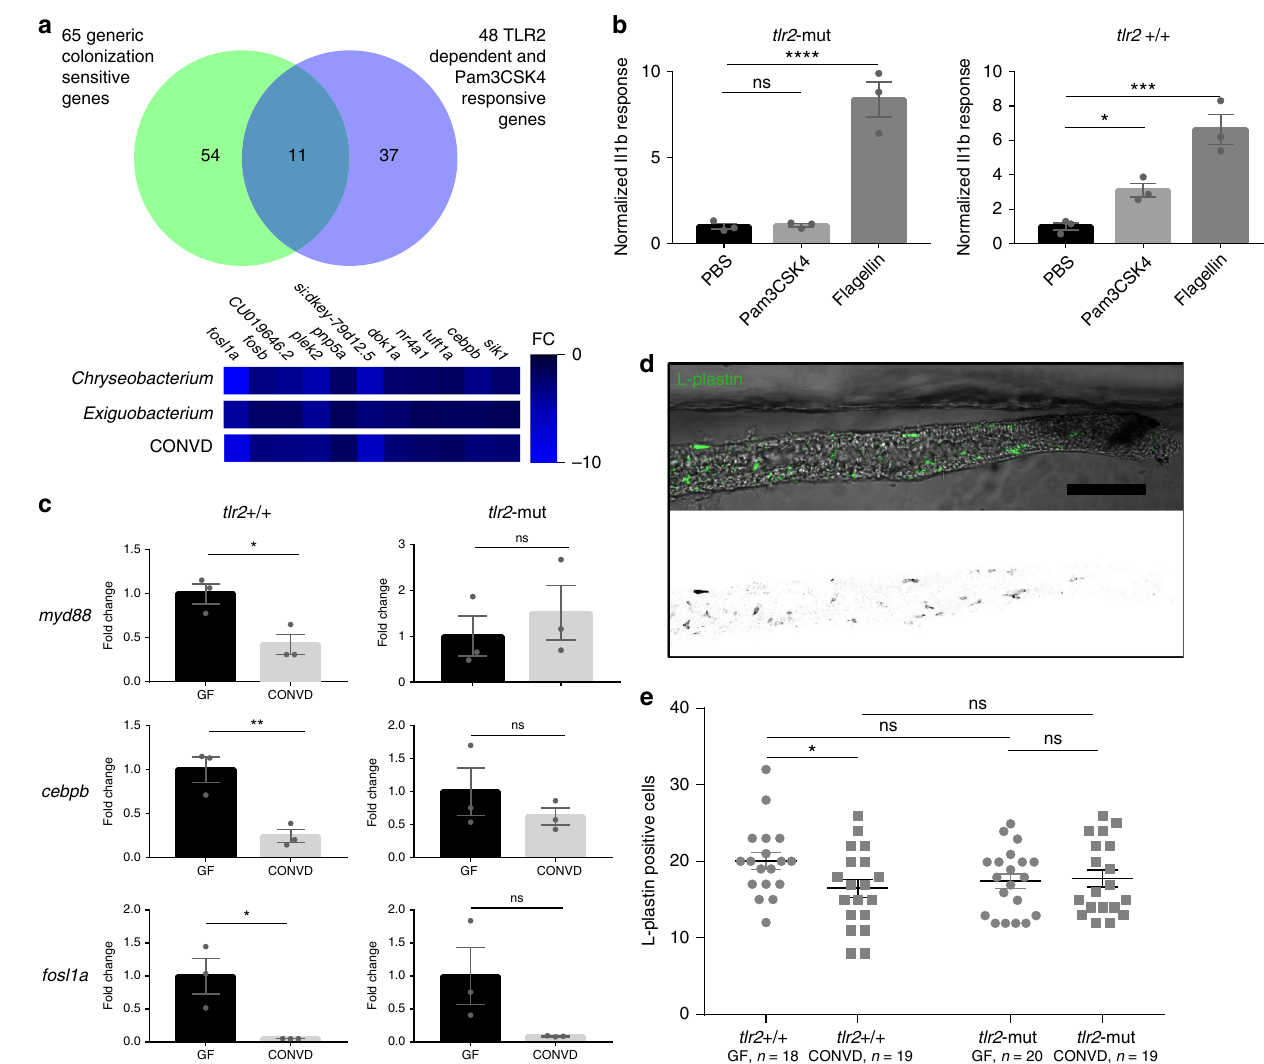
Fig. 4 Microbiome transcriptional control of myd88 is dependent on Tlr2. a Venn diagram showing the overlap between the identities of 65 primarily suppressed transcripts displaying transcriptional sensitivity to all the different colonization modes tested in this study, and thus are strong markers of the shared transcriptional response, with 48 primarily induced transcripts displaying Tlr2 dependent transcriptional sensitivity to injection of the synthetic ligand Pam3CSK4. 11 transcripts were shared among the two sets, all of which are suppressed by colonization, but induced by Pam3CSK4 in a Tlr2 dependent manner. b Q-PCR analysis comparing the in fl ammatory il1b response to injection of Tlr2 ligand (PAM3CSK4), Tlr4 ligand (LPS) and control (PBS) in Tlr2-mut and Tlr2 + / + 1 h after injection. (mean ± s.e.m., n = 3 biological replicates, 10 embryos per group), * P ≤ 0.05 *** P ≤ 0.001; **** P ≤ 0.0001, by Student ’ s t -test. c Q-PCR analysis comparing the relative expression levels of myd88, fosl1a and cebpb , in conventionalized (CONVD) versus germ-free (GF) conditions in Tlr2 de fi cient mutants versus WT siblings. (mean ± s.e.m., n = 3 biological replicates, 15 embryos per group), * P ≤ 0.05; ** P ≤ 0.01, by Student ’ s t -test. d Representative image of intestines excised from L-plastin stained embryos. Scalebar represents 100 µ m. e The elevated leukocyte presence under germfree conditions in the WT siblings was not observed in Tlr2 mutants. Figure is representative of three independent replications, * P ≤ 0.05; by two-way ANOVA with Bonferroni correction for multiple comparisons, error bars represent standard error of the